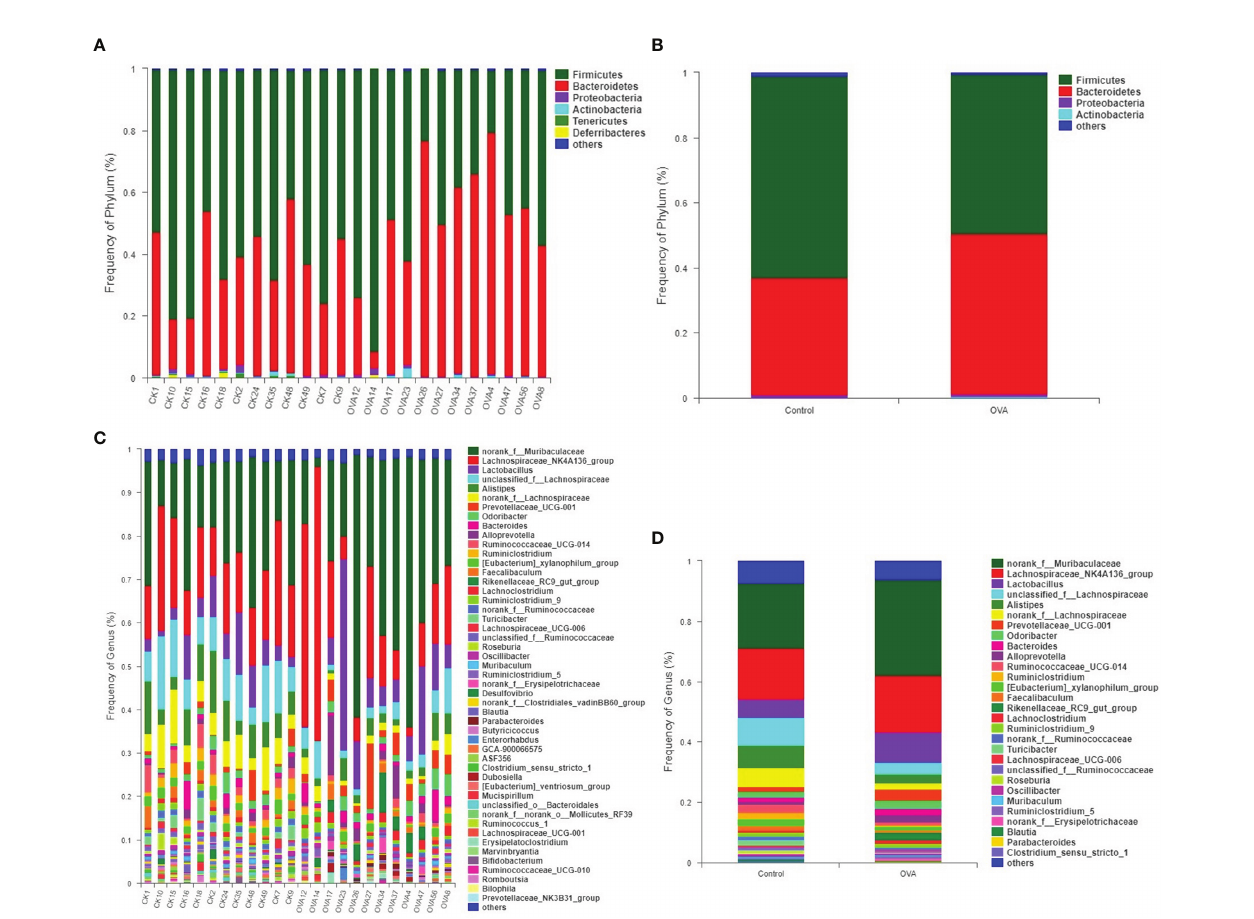
FIGURE 6 | Distribution of fecal bacterial communities at the phyluam and genus levels for all mice. (A, B) show the phylum level; (C, D) show the genus level. (A, C) represent the intestinal fl ora composition of each sample, while (B, D) represent that of different